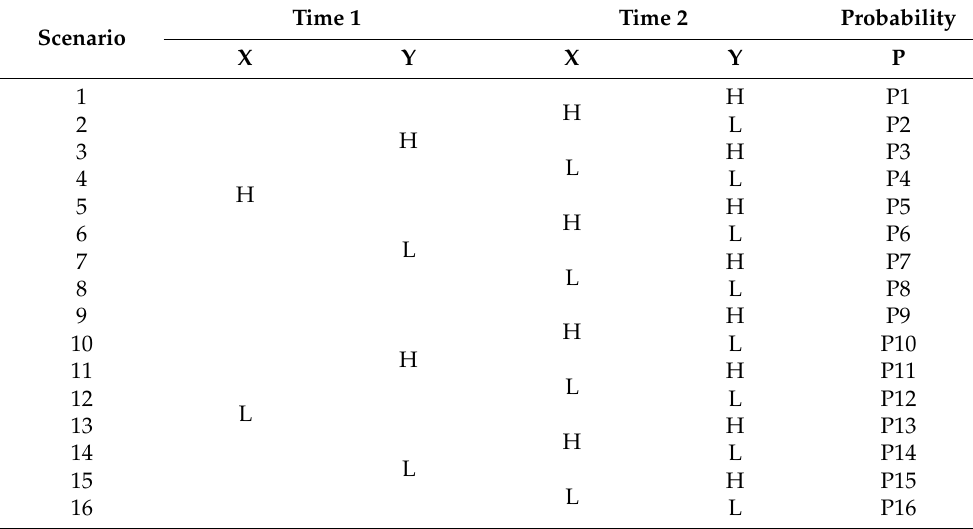
Table 1. Scenario table for uncertain parameters. L = Low, H = High. Time 1 Time 2 Probability Scenario X Y X Y